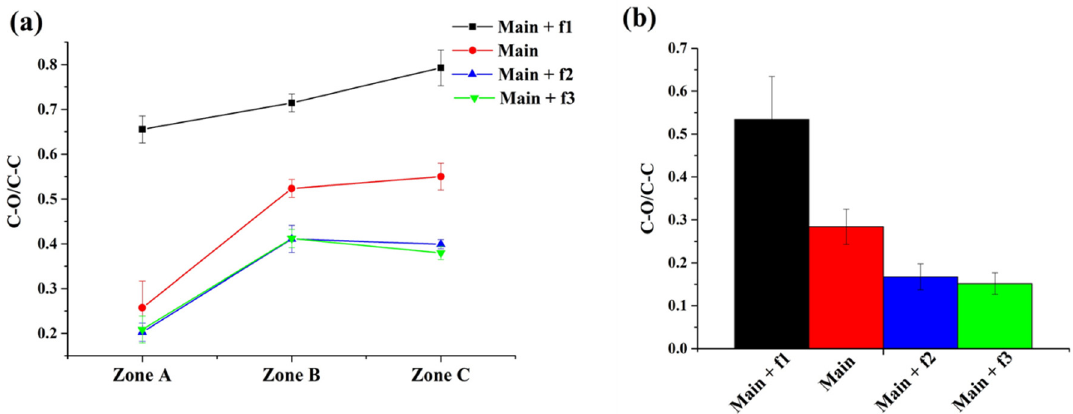
Figure 11. Influence of carrier gas flow rate on C-O/C-C ratio for ( a ) styrene and ( b ) MMA samples.